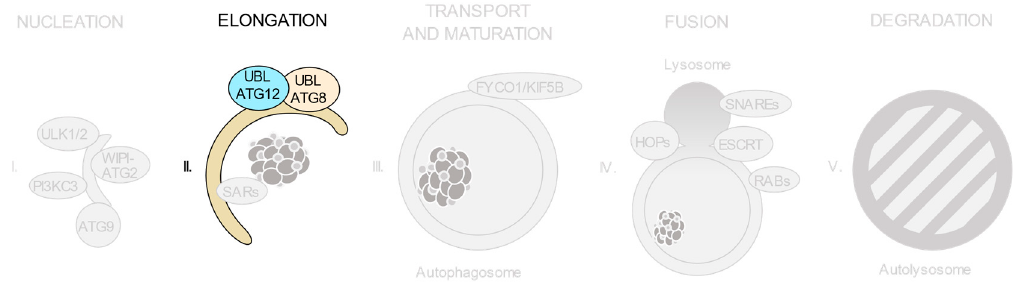
Figure 6. The ubiquitin-like (UBL) conjugation systems of ATG12 and ATG8 participate in the elongation of the pre-autophagosomal membrane.